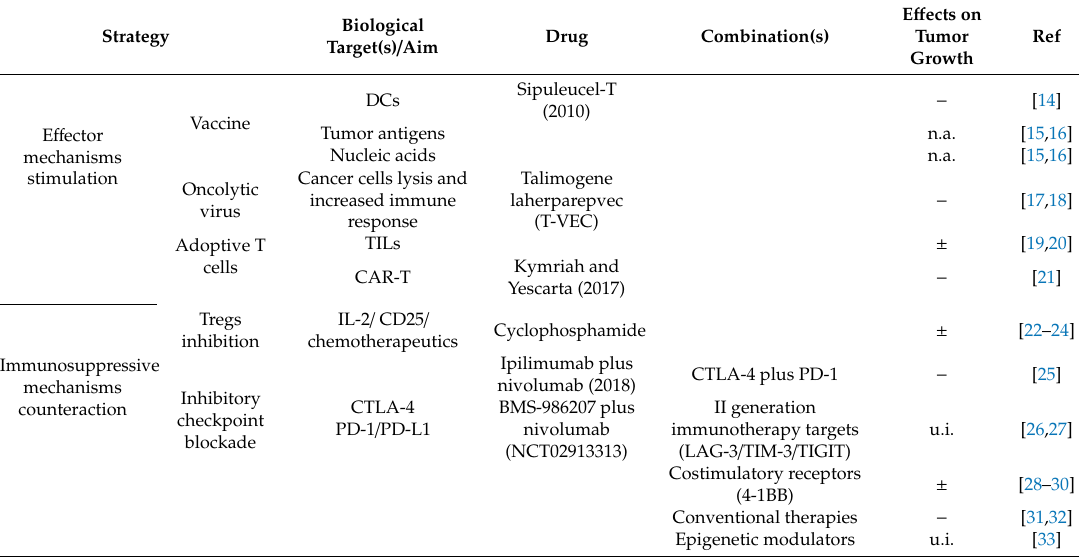
Table 1. Immunotherapy strategies against